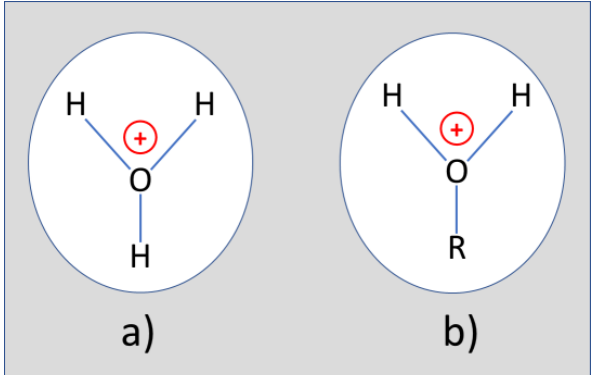
Figure A4. ( a ) H 3 O + ion dissolved in a phosphate-ester fluid; ( b ) split-off hydrocarbon side group after capture of a proton from an acid partial phosphate.